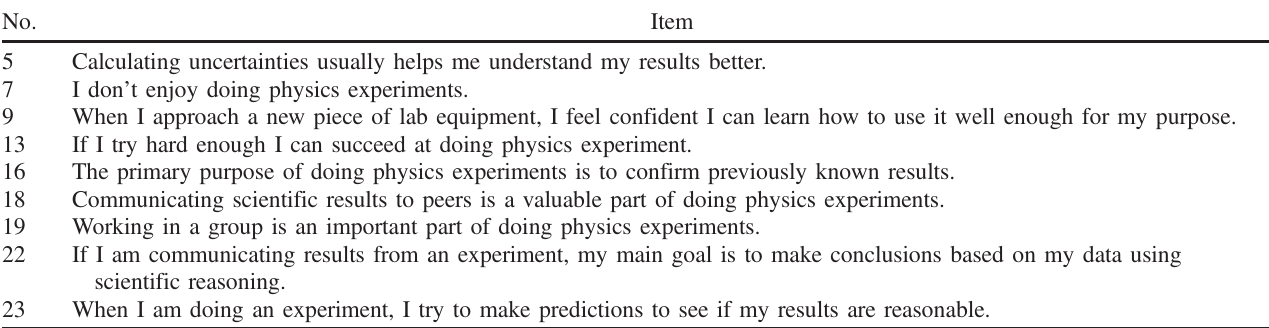
TABLE I. E-CLASS items that are related to learning goals of the AT course. No. Item